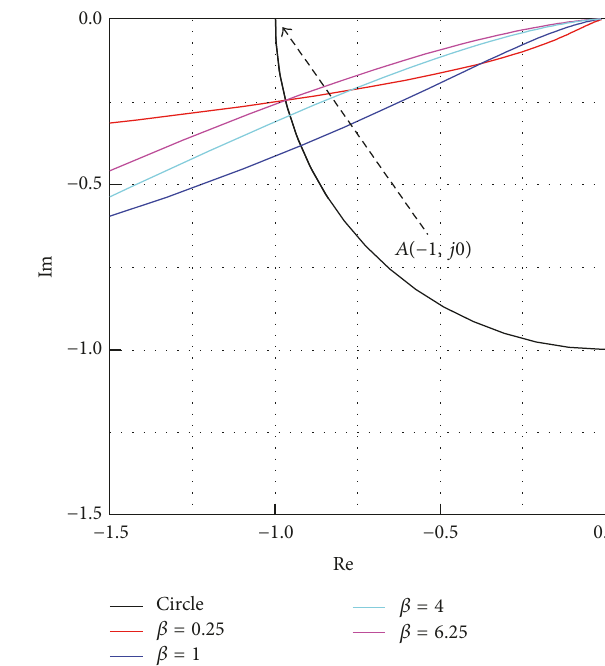
Figure 13: Nyquist diagram ( 𝛼 = 1.5 ).